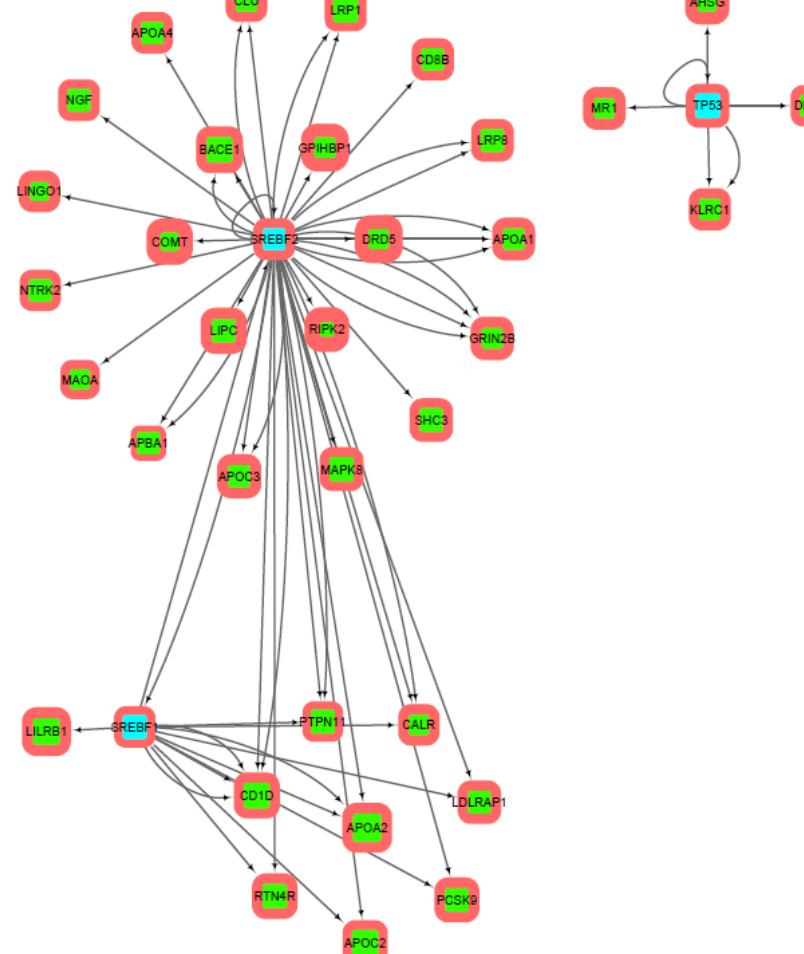
Figure 3. Transcriptional regulation network built on predictions of transcription factor binding sites in upstream promoter regions of 300 b.p. length. Transcription factors are cyan highlighted, green are regulated genes. Direction of arrows denote regulators (from) and regulated genes (to). The thickness of the frame corresponds to the enrichment of SNP in the upstream promoter region of the gene, the size of the node—the enrichment of SNP in the coding region of the